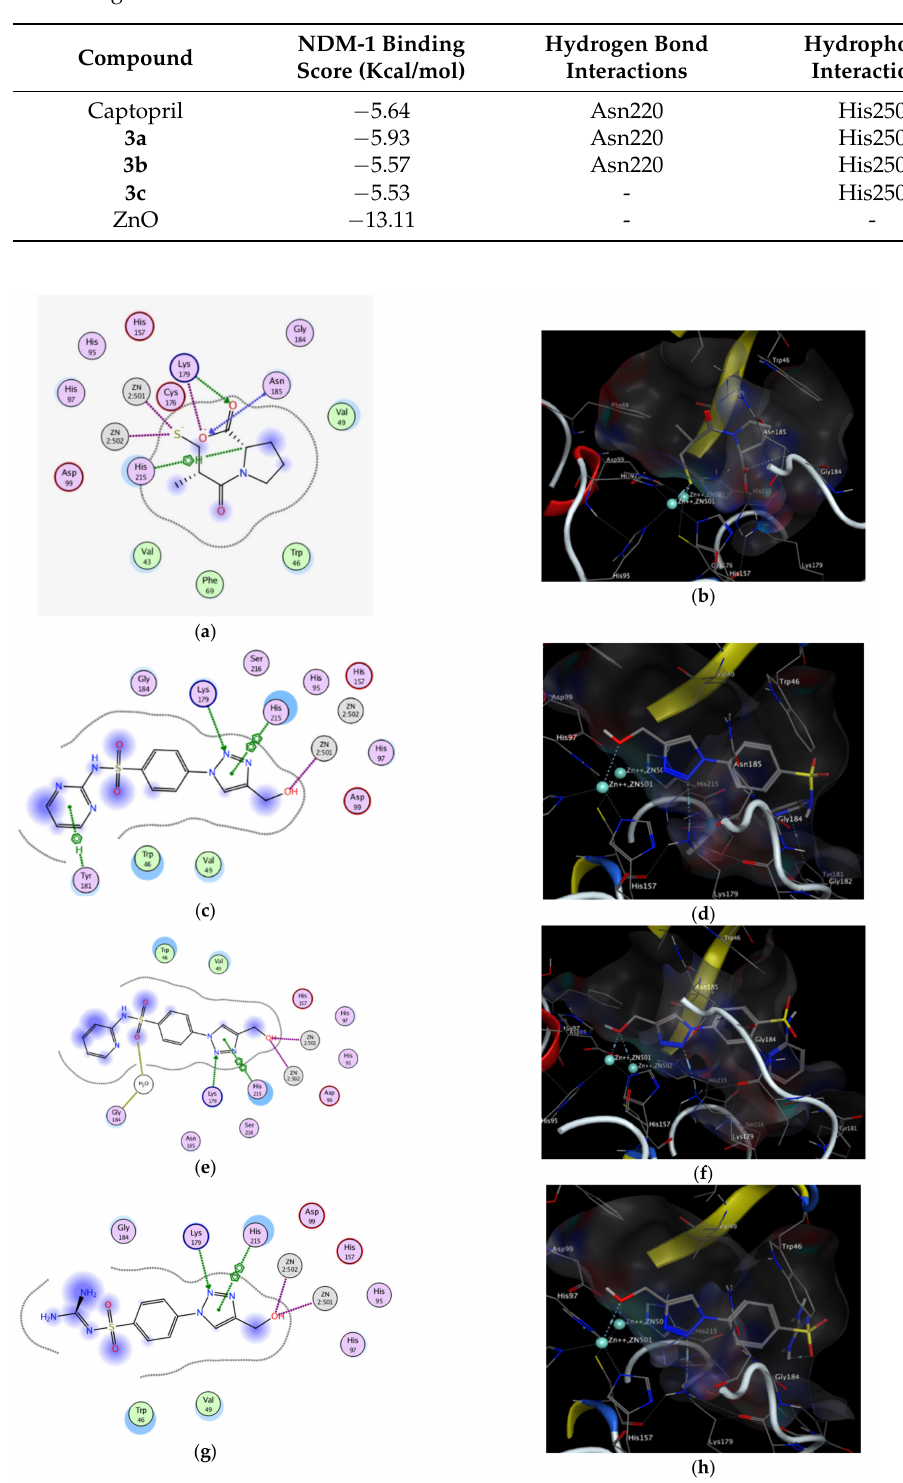
Table 2. Binding scores and binding interactions of the investigated compounds with NDM-1 active site. Biological evaluations.